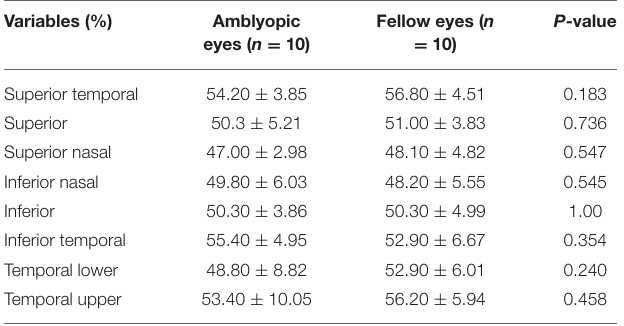
TABLE 3 | Eight-sector peripapillary capillary small vessel density in amblyopic and fellow-subjects.